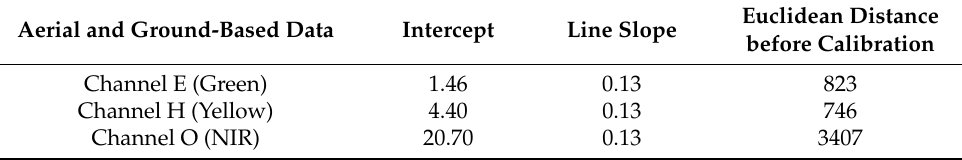
Table 9. Aerial and ground-based spectrometer intercept, line slope, and Euclidean distance before